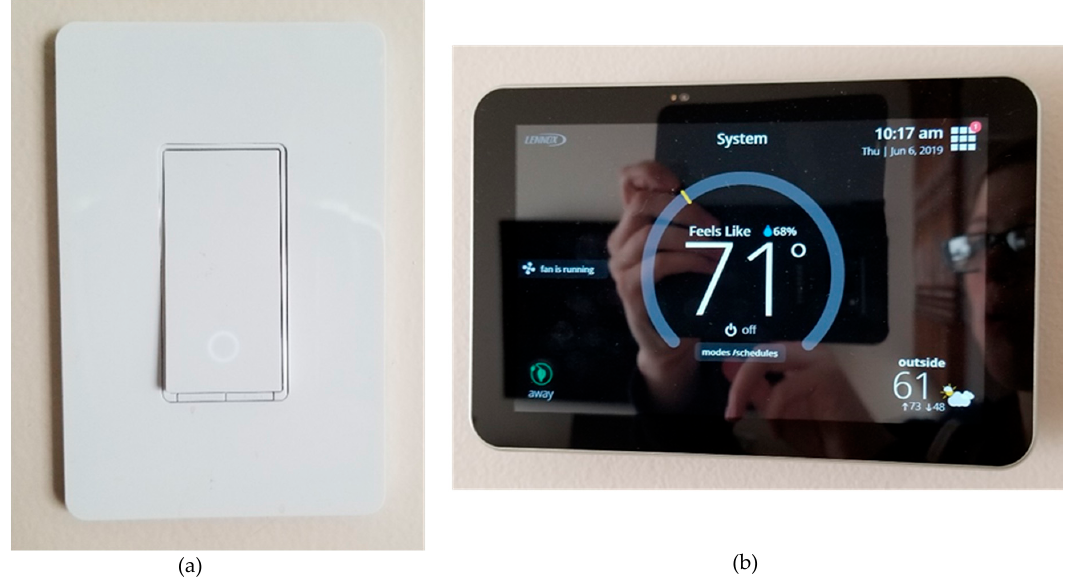
Figure 17. ( a , b ) A networked light switch and temperature sensor in a home. Permission grant and photographs taken by Istead.